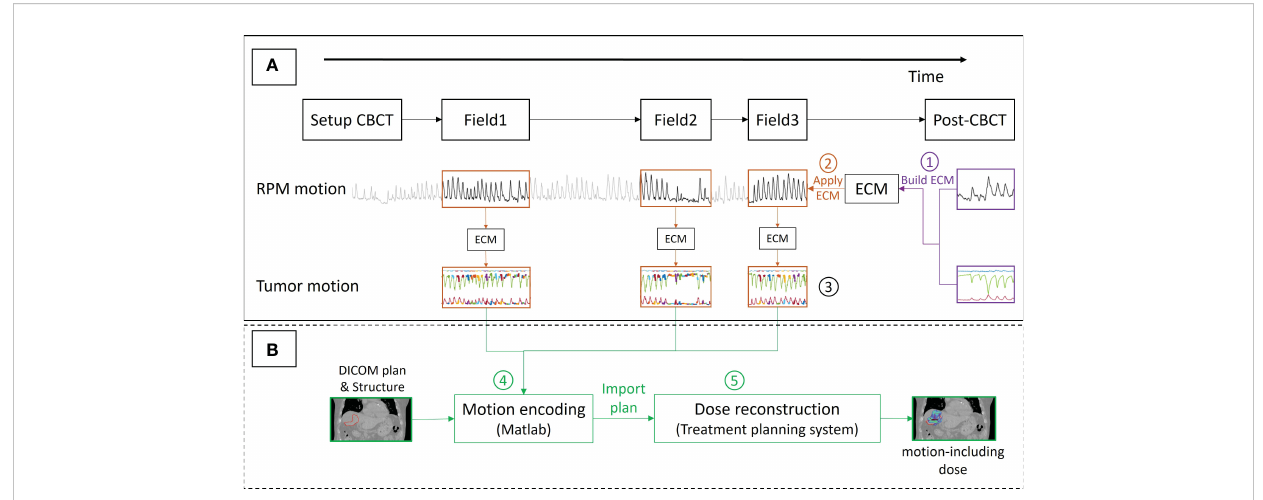
FIGURE 2 Work fl ow for (A) estimating the tumor position at the time of delivery of each spot by an external-internal correlation model (ECM) and (B) motion- including dose reconstruction. The numbers refer to the description in the text. The thick colored curves shown on the top of the tumor motion (Label 3) show the spot delivery times with different energy layers indicated with different colors.